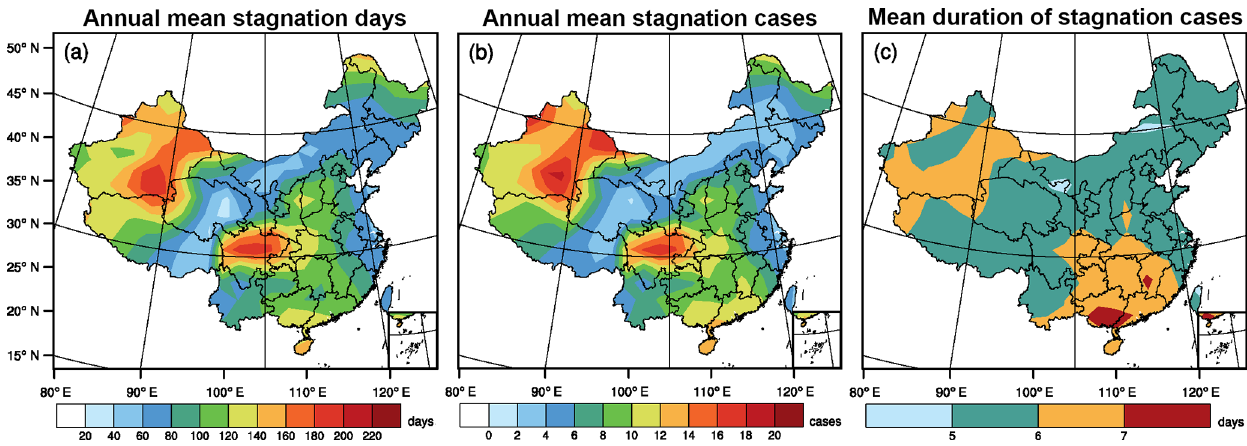
Figure 2. Annual mean air stagnation days (a) and cases (b) and the mean duration of stagnation cases in days (c) for China (1985–2014).